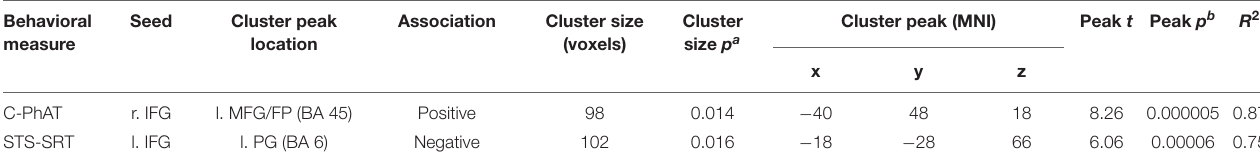
TABLE 2 | Statistically significant associations between Sign Language Proficiency Variables (STS-SRT and C-PhAT) and Resting-State Functional Connectivity, controlling for age. Behavioral measure